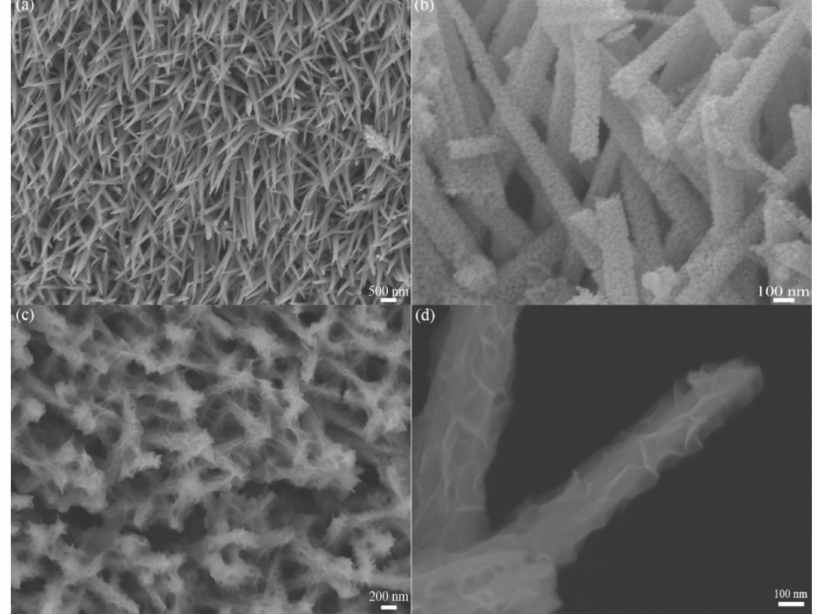
Figure 3. SEM images of ( a , b ) NiCo 2 O 4 nanowires on Ni foam and ( c , d ) MnO 2 @NiCo 2 O 4 under di ff erent magnifications.